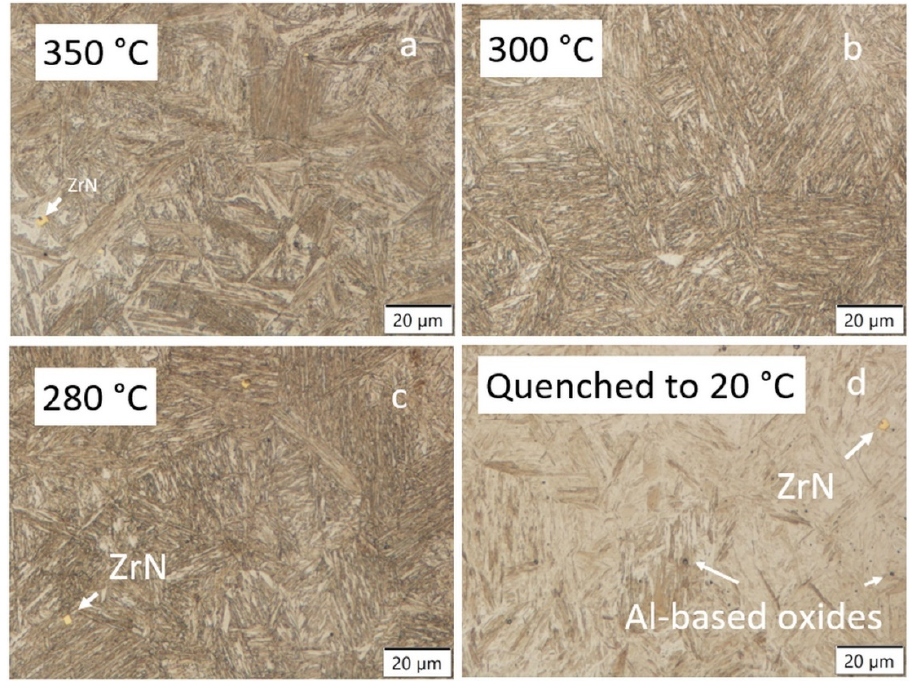
Figure 8. LOM of the dilatometric samples according to the heat treatment cycle presented in Figure All samples austenitized at 920 ◦ C with 20 min of holding time and isothermal holdings: ( a ) 350 ◦ C, 1. All samples austenitized at 920 °C with 20 min of holding time and isothermal holdings: ( a ) 350 °C, 2 h, ( b ) 300 °C, 2 h, ( c ) 280 °C, 1 h. ( d ) Quenched to 20 °C to obtain a fully martensitic structure. 2 h, ( b ) 300 ◦ C, 2 h, ( c ) 280 ◦ C, 1 h. ( d ) Quenched to 20 ◦ C to obtain a fully martensitic